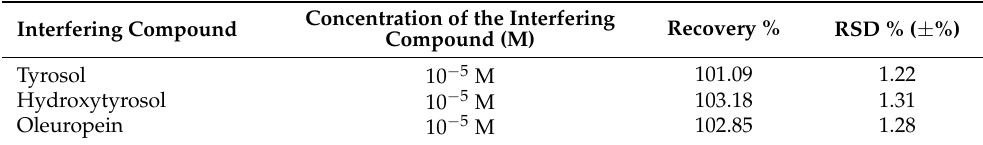
Table 4. Interference of some organic compounds on verbascoside